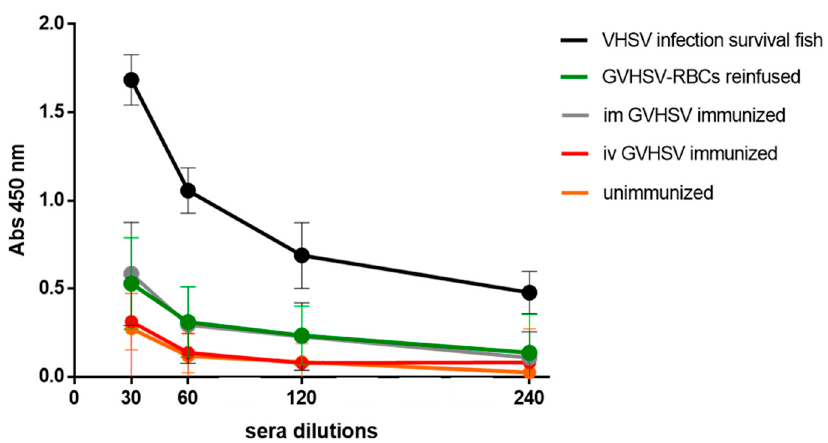
Figure 7. The VHSV-specific antibody detection in serum of GVHSV-transfected RBCs-reinfused / immunized fish. Serum dilution from: (i) im GVHSV-immunized individuals, (ii) iv GVHSV-immunized individuals, and (iii) iv GVHSV-transfected RBCs-reinfused / immunized individuals. Serum obtained from VHSV-challenged survivor trout was used as a positive control, and serum from unimmunized, uninfected fish was used as a negative control. Anti-VHSV antibodies were detected by absorbance readings at 450 nm. Results are expressed as mean ± SD of absorbance ( n = 4), performed in triplicate.